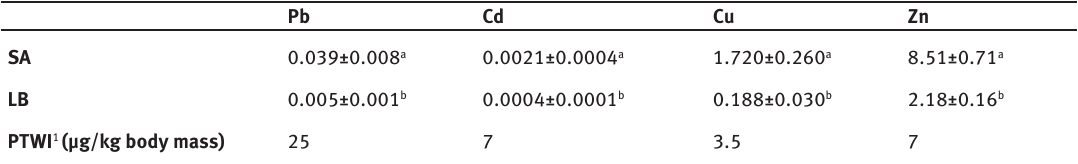
Table 4: Content of lead, cadmium, copper and zinc [mg/kg product] in butter milk from various regions of Poland. Pb Cd Cu Zn SA